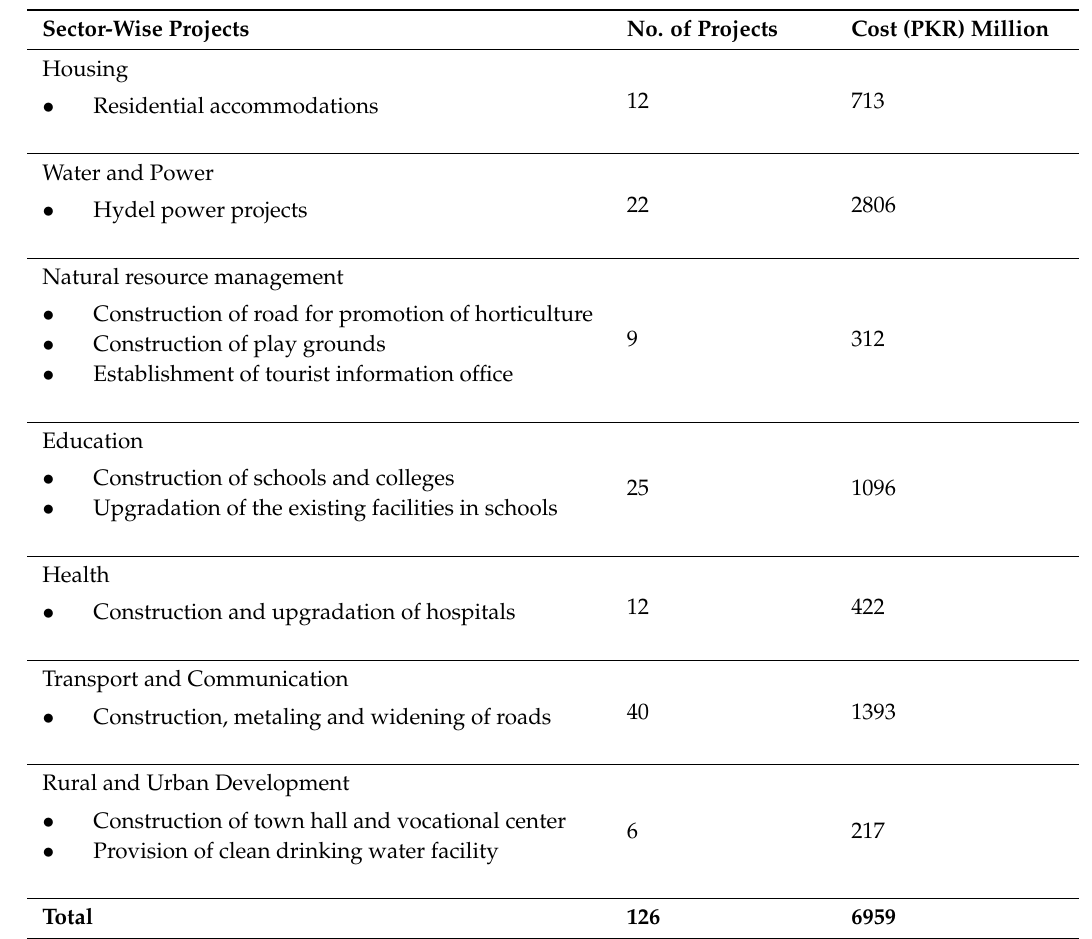
Table A1. Sector wise distribution of